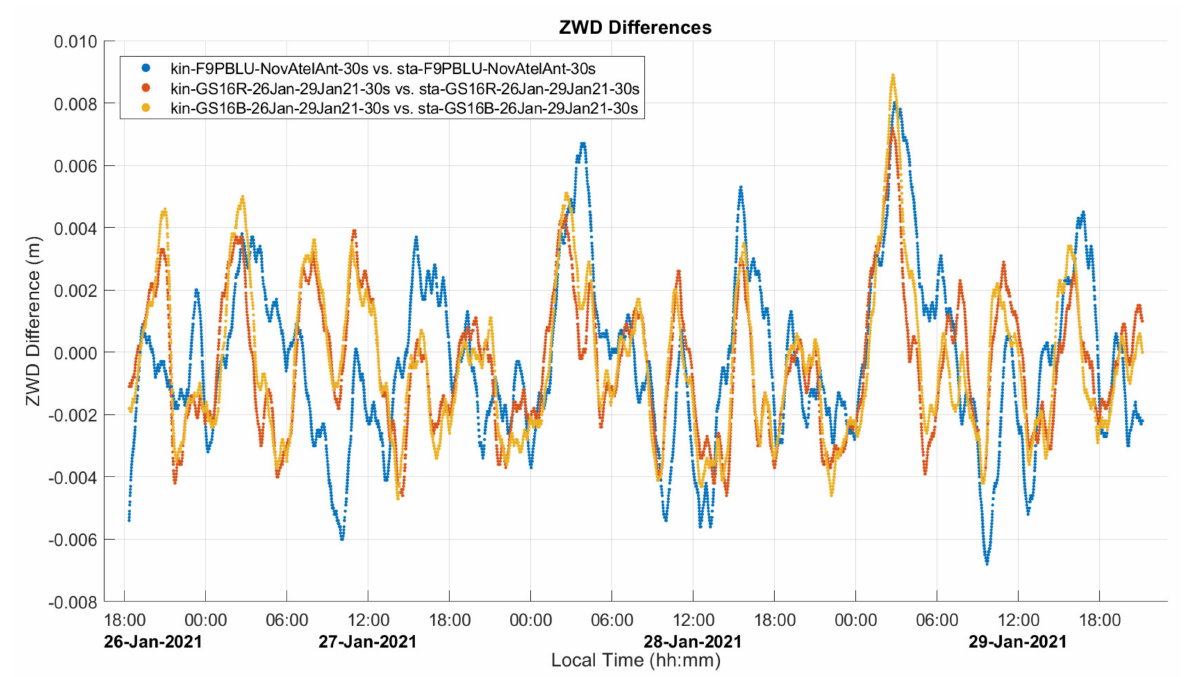
Figure 11. Static dataset A ZWD differences between static and kinematic solutions. Local time is UTC −